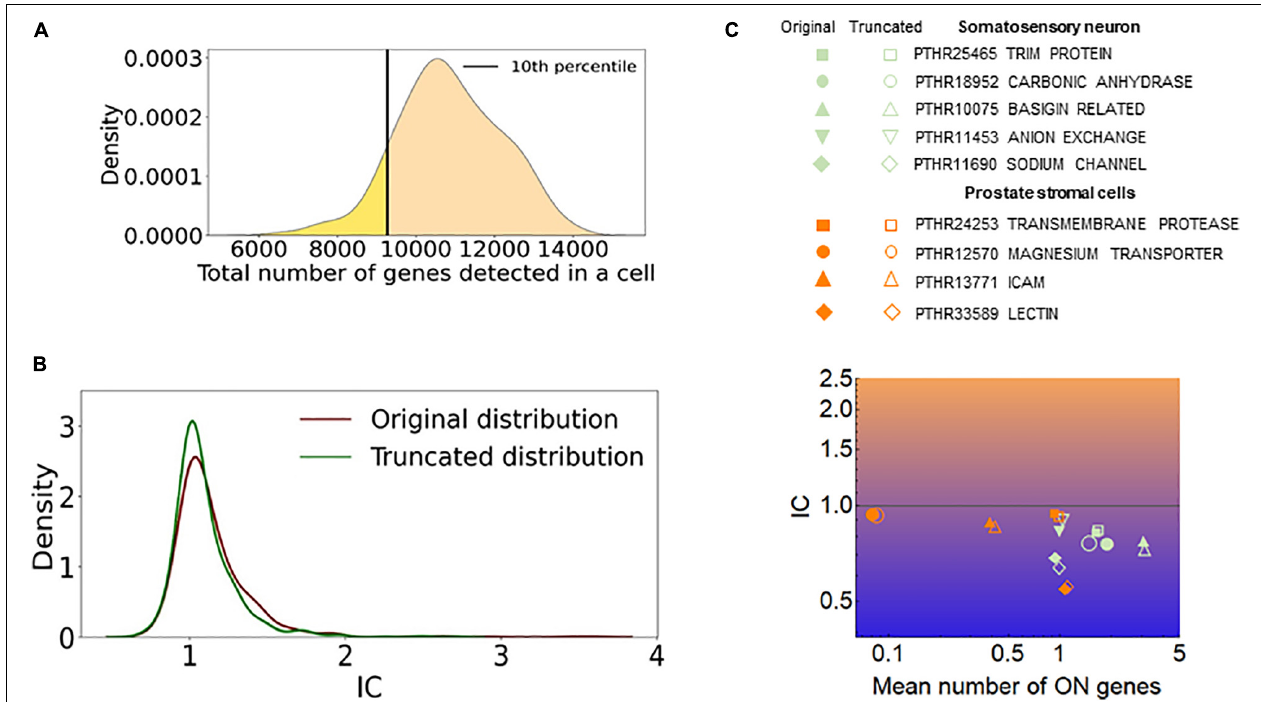
FIGURE 9 | The effect of cells with low number of detected genes on the IC. (A) The distribution of the total number of detected genes per cell (dgpc) in the somatosensory neuron dataset. The black line indicates the dgpc below which the cells were removed to obtain the truncated distribution. (B) The distribution of IC values of gene families calculated from the original and truncated cell populations shown in (A) . (C) The IC and the mean number of ON genes calculated with the original (full) and the truncated (empty) datasets. The prostate stromal cell and the somatosensory neuron datasets were